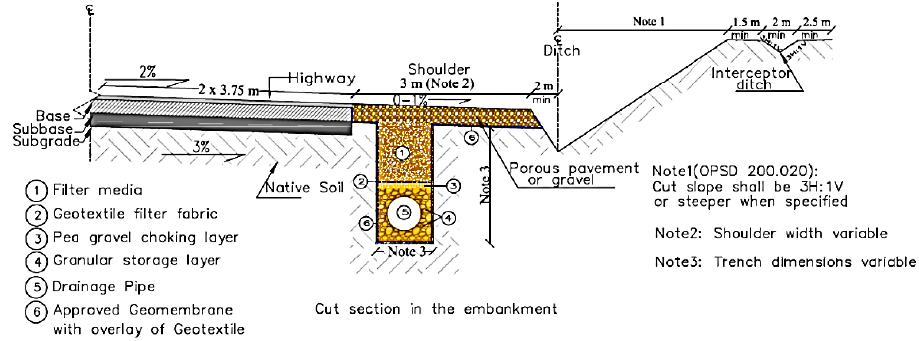
Figure 4. The ERDS design on the shoulder of Highway 407 and 401.